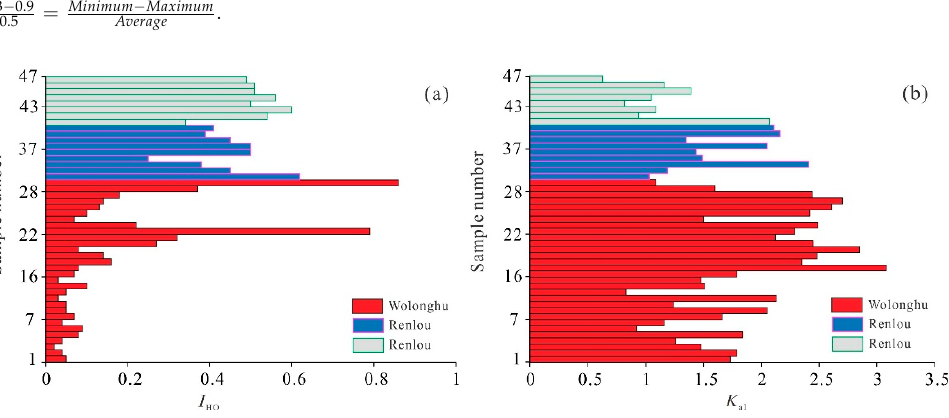
Figure 6. I HO ( a ) and K al ( b ) distributions of the selected coal samples from the Huaibei